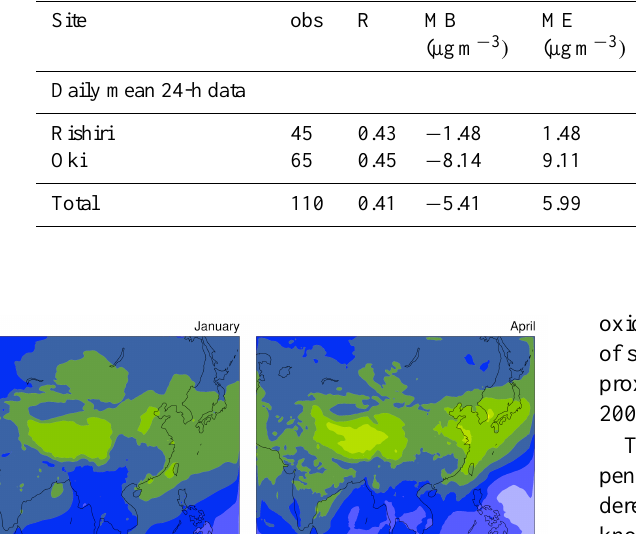
Table 8. Statistical measures for model performance evaluation for PM 2 . 5 for the year 2000.